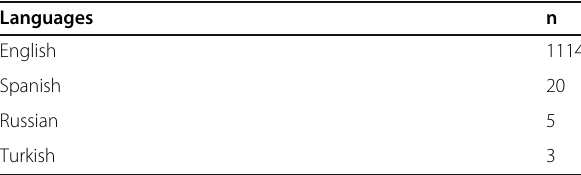
Table 2 Scientific languages used